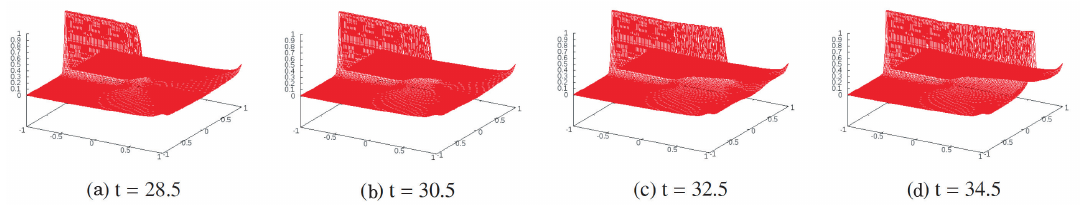
Figure 5. Time evolution of the phase-field variable z ( x , t )